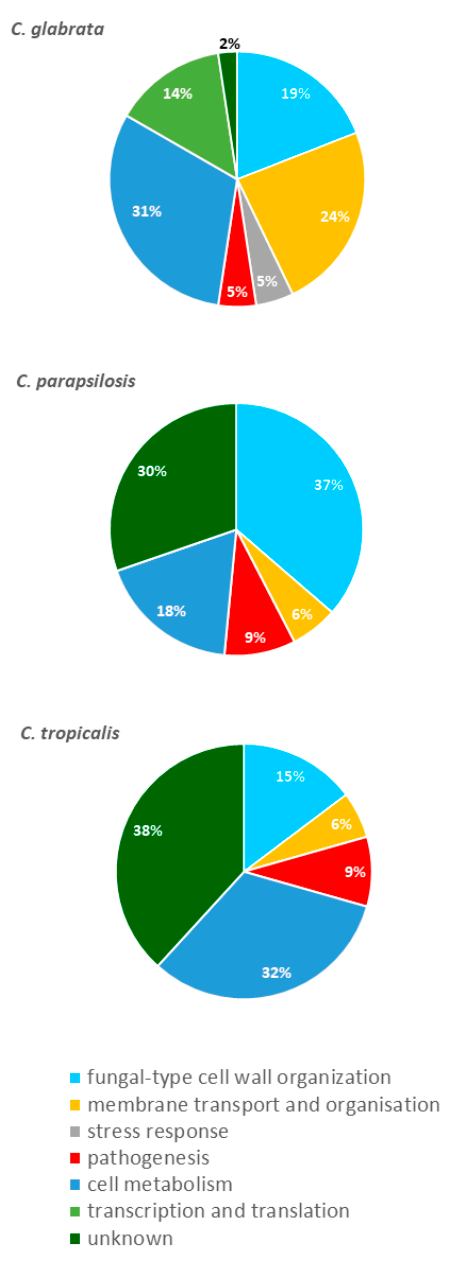
Figure 4. Distribution of EV proteins in C. glabrata , C. parapsilosis and C. tropicalis within major functional groups for similar cellular processes.